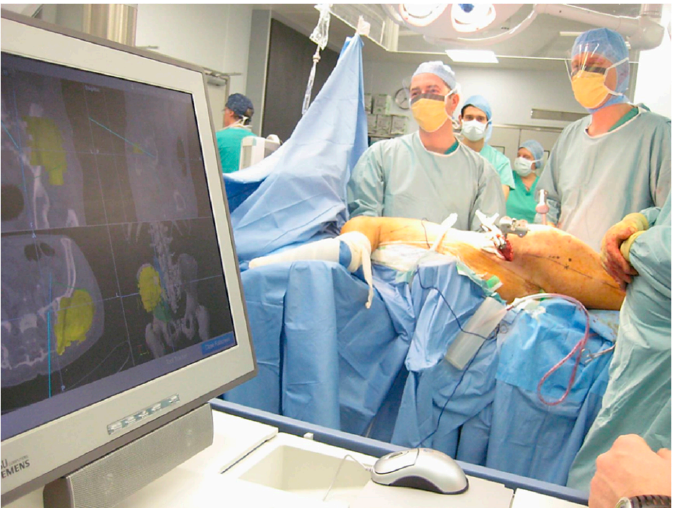
Figure 5. CANS in use for a pelvic tumour resection. The screen on the left shows the bone-tumour model with the position of the navigation probe